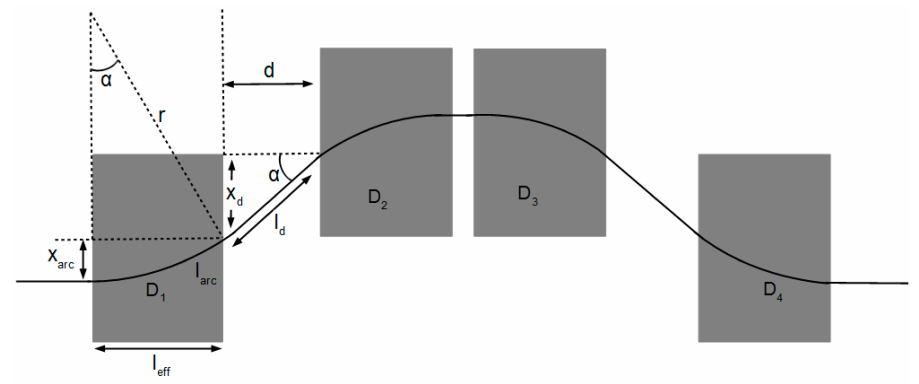
Figure 6. Scheme of the ELIMED ESS